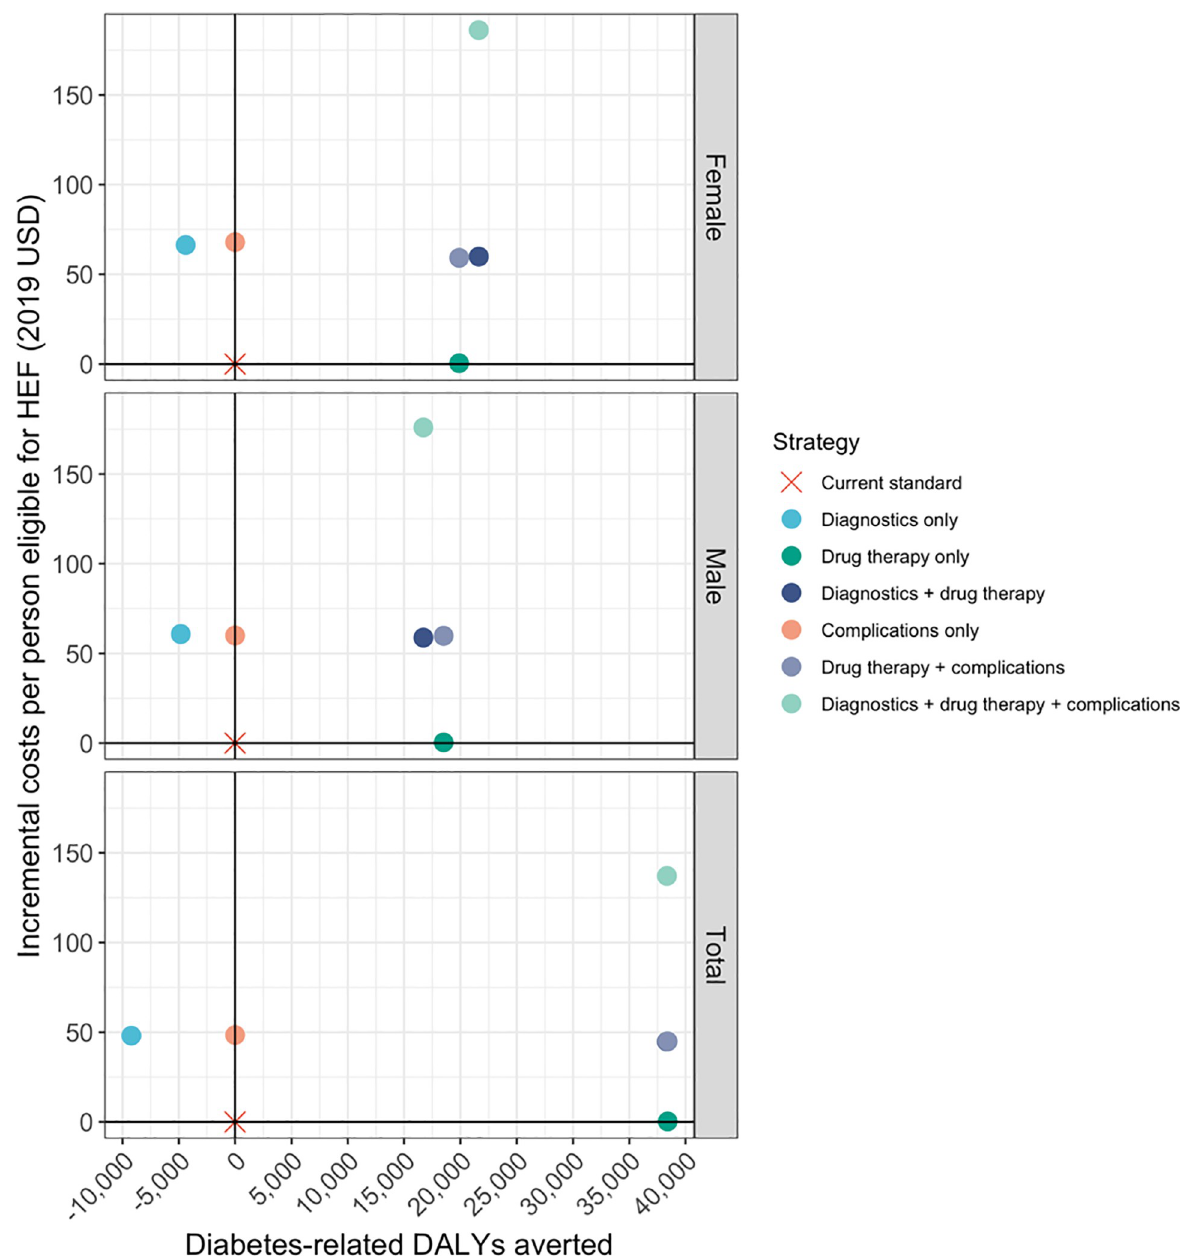
Fig 2. Incremental total costs per person eligible for HEF (poorest 20%) vs. diabetes-related DALYs averted by population group and